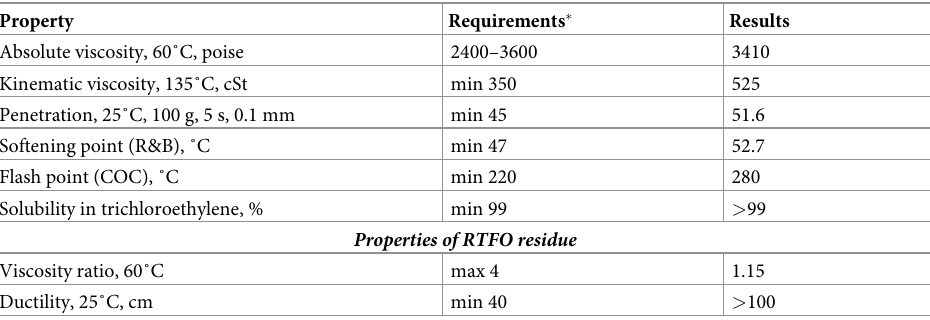
Table 1. Properties of base bitumen (VG30).